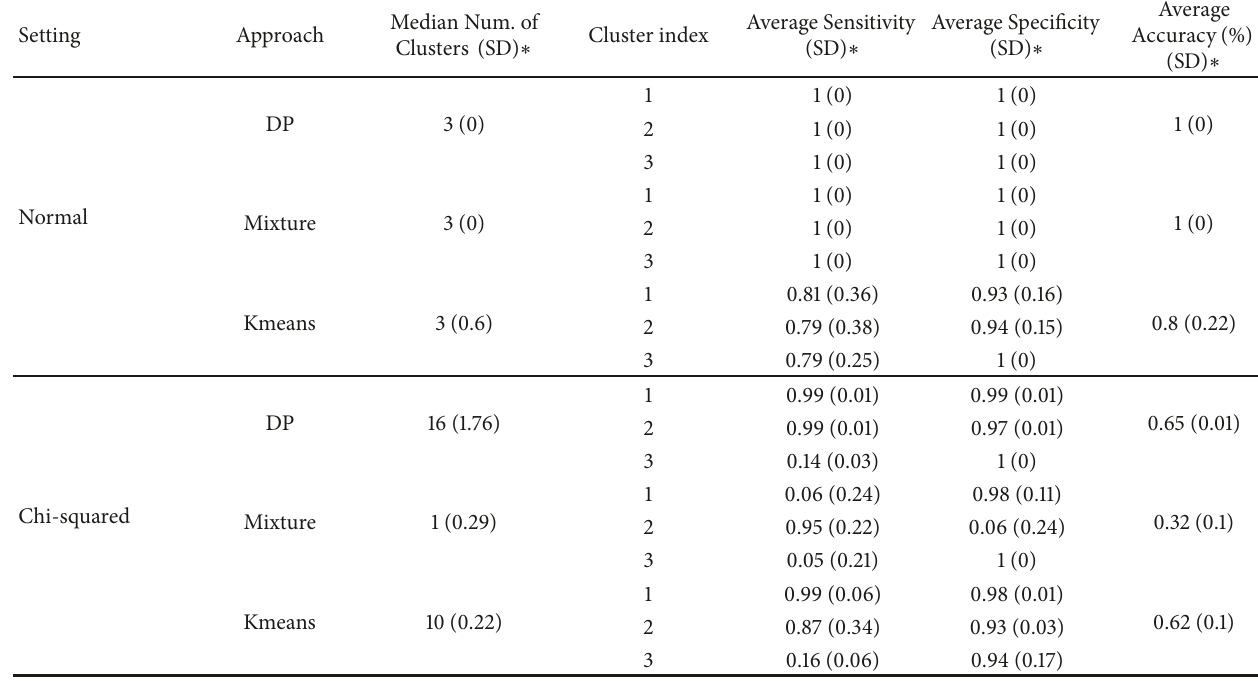
Table 3: Comparison of approaches for selected simulated settings assuming study effect is known.